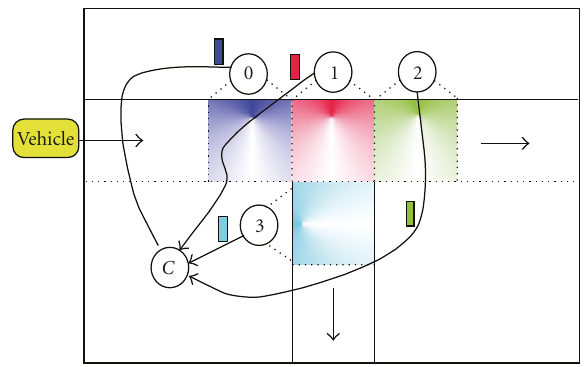
Figure 24: The scenario used for RTNS simulation. Nodes 0,1,2,3 track a vehicle using embedded pin-hole cameras covering com- plementary views. They send detection reports to the coordinator whenever they recognize the target entered their camera view.